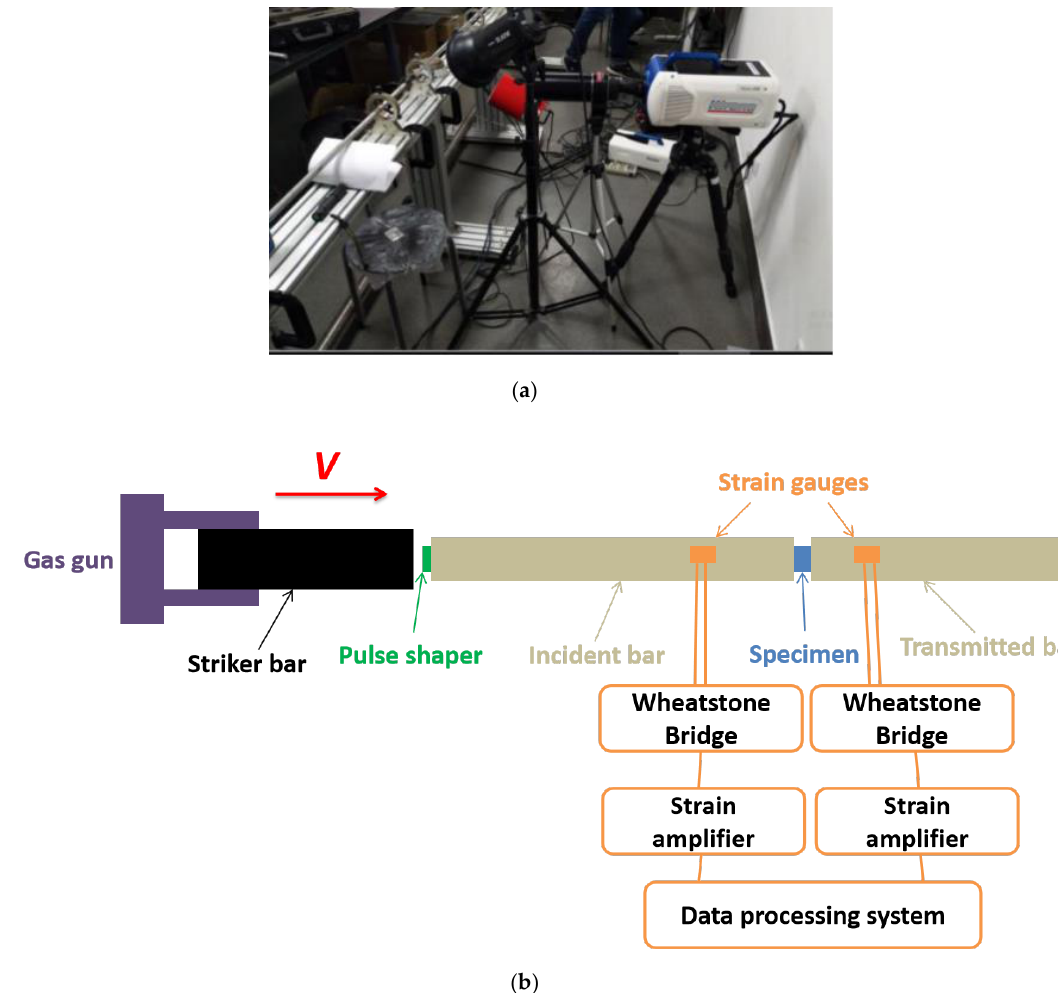
Figure 2. ( a ) A photograph of the split Hopkinson pressure bar device fitted with a high-speed digital camera. ( b ) Scheme of the split Hopkinson pressure bar device.